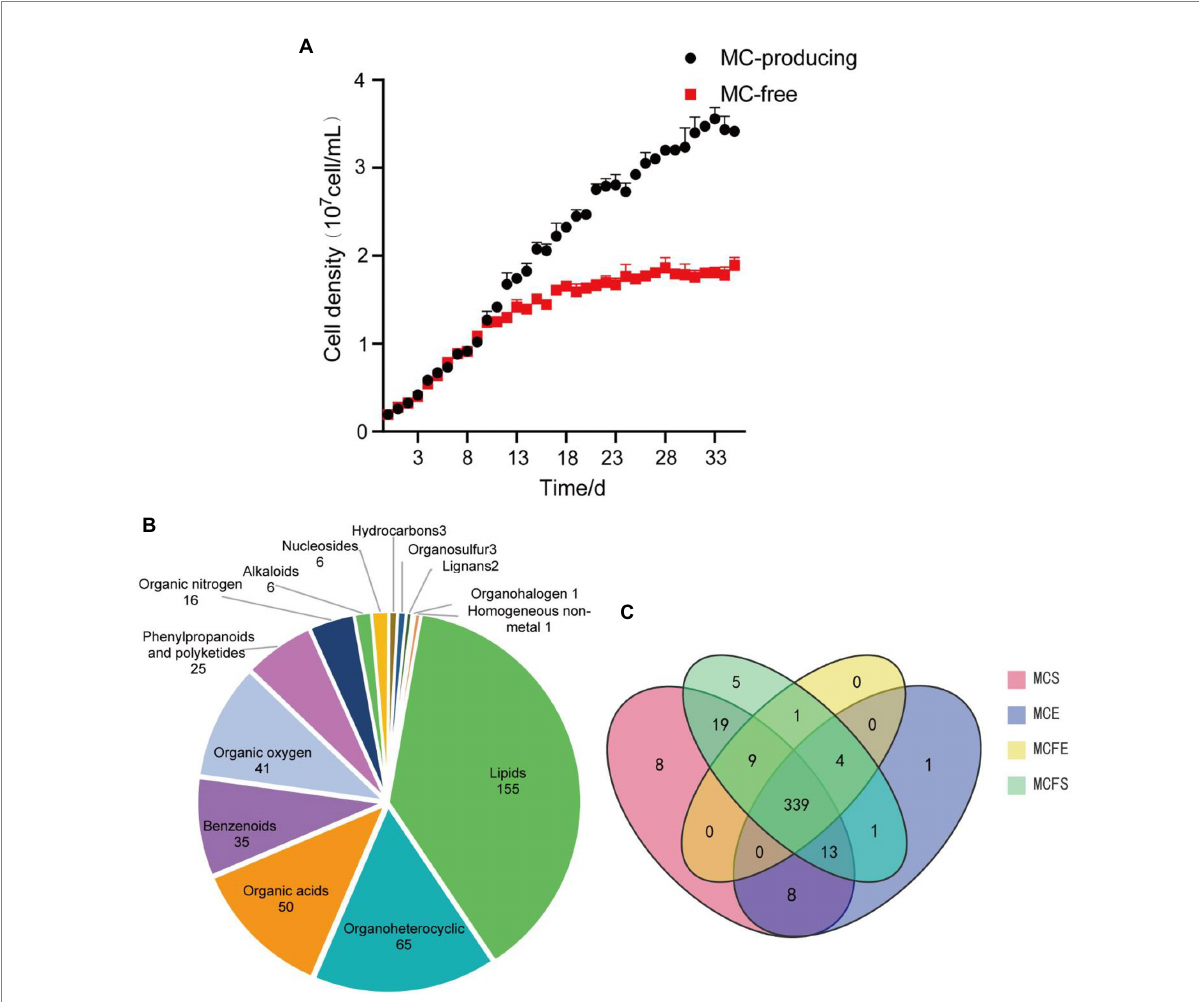
FIGURE 1 Growth curves of the MC strain and MC-free strain, data are presented as means±standard deviation ( n = 6; A ). Pie diagram showing classification of 409 total metabolites identified in MaE (B) ; Venn diagram of metabolites distribution in four groups, with numbers representing metabolites in common (C) . MCE, MC-producing strain at exponential phase; MCFE, MC-free strain at exponential phase; MCS, MC-producing strain at stationary phase; MCFS, MC-free strain at stationary